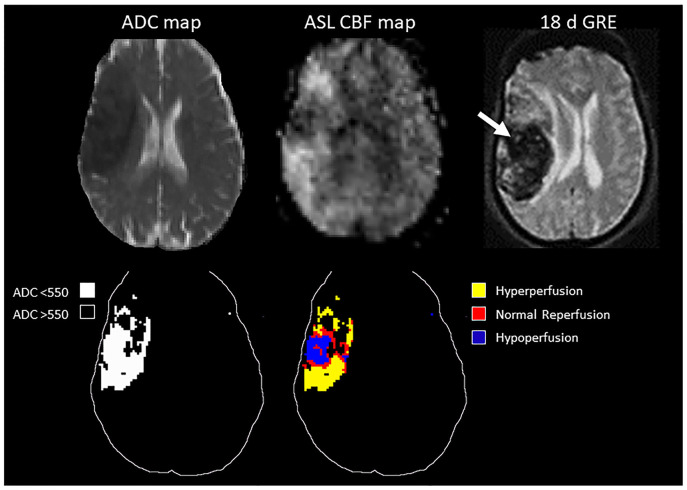
Top: MRI of a 78 year old patient with MCA stroke. IV tPA was given 2 h after onset, followed by clot retrieval at 4.7 h after onset. Post-treatment ASL showed variable reperfusion, and subsequent hemorrhage was observed in GRE at a later time point. Bottom: schematic drawing of the ADC-thresholded lesion volume, and the reperfusion volume distribution within the lesion.